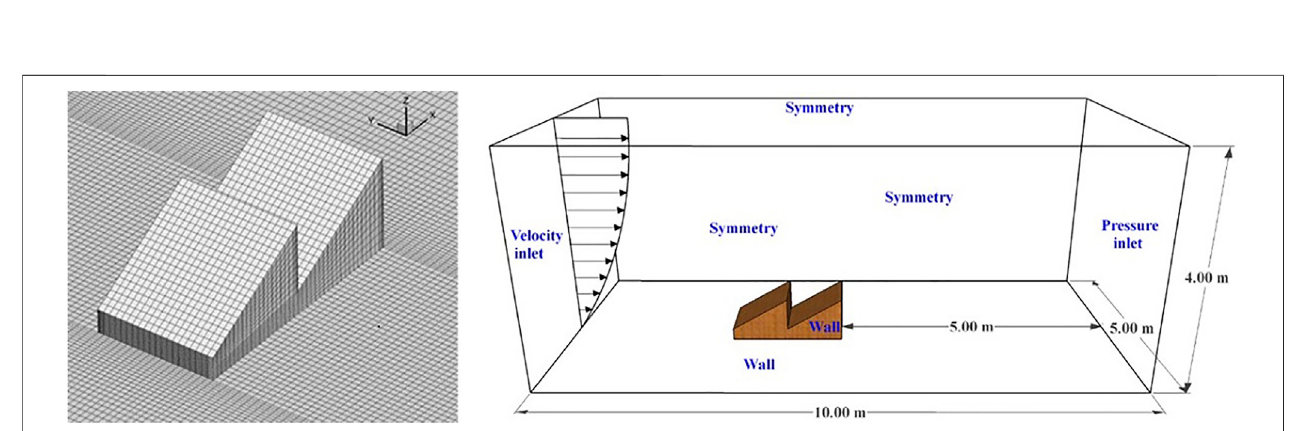
FIGURE 14 | The meshing method and computational settings (Roof pitch = 30 °